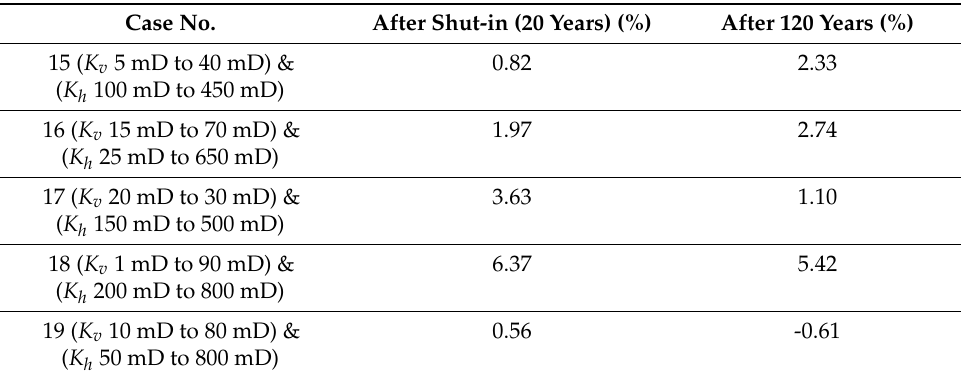
Table 4. Data of increase/decrease of CO 2 dissolution in brine for different ranges.